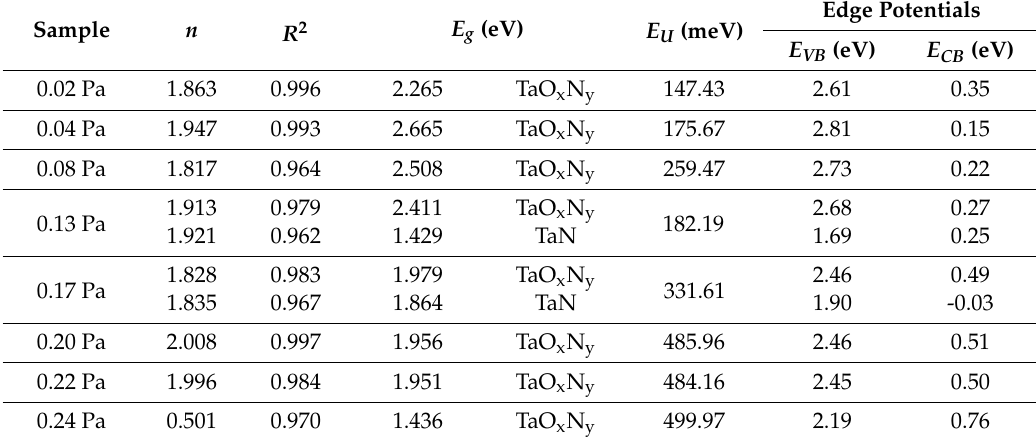
Table 2. Parameters associated with the Tauc plots. The column titled E U refers to Urbach energy. Sample